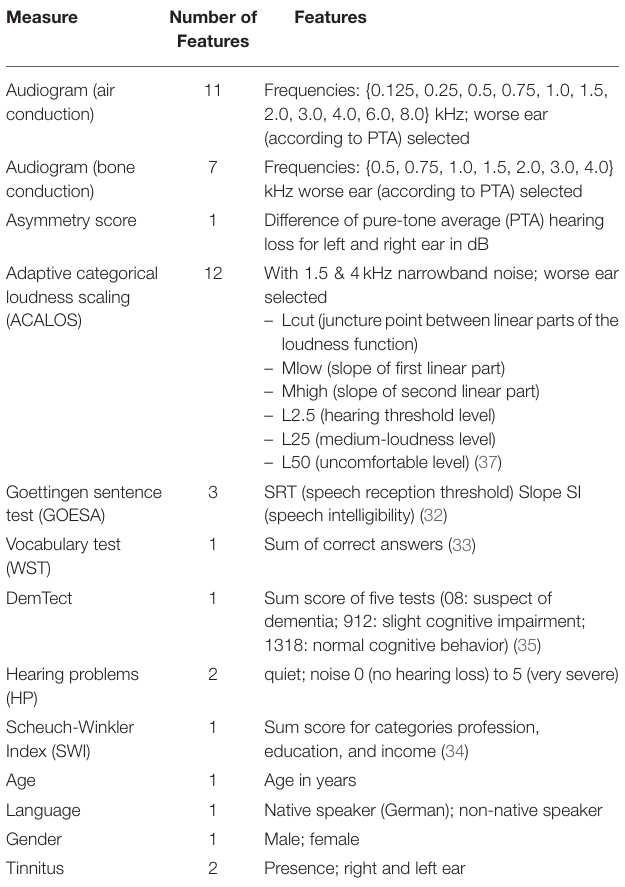
TABLE 2 | Overview of audiological measures and features. Measure